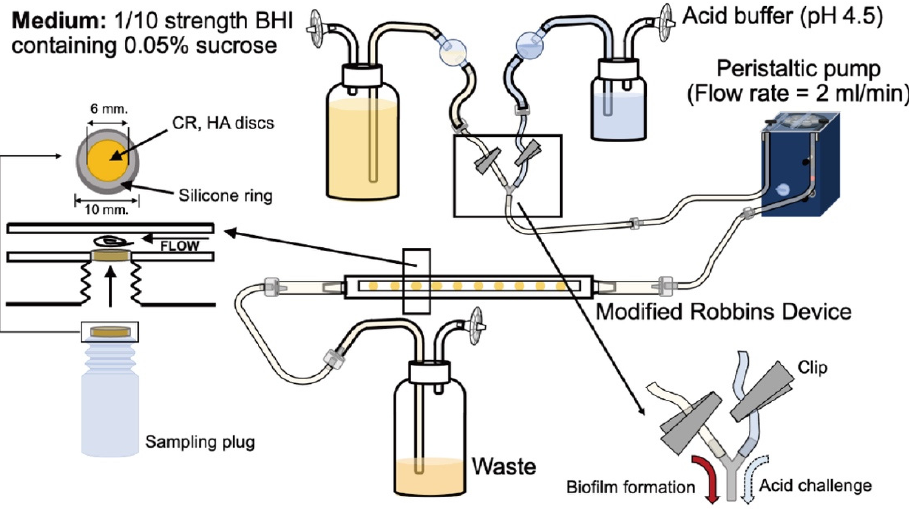
Figure 6. Modified Robbin device used in this